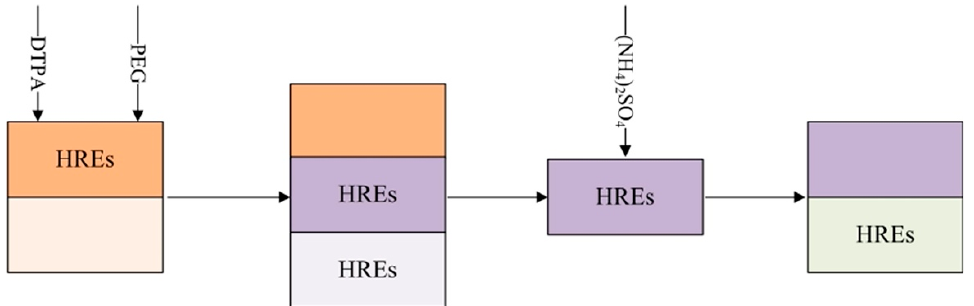
Figure 3. Schematic diagram for stripping of HREs. Adapted with permission from [54]. Copyright